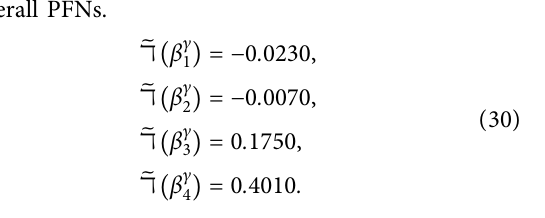
( i � 1 , 2 , 3 , 4 ) according to the i